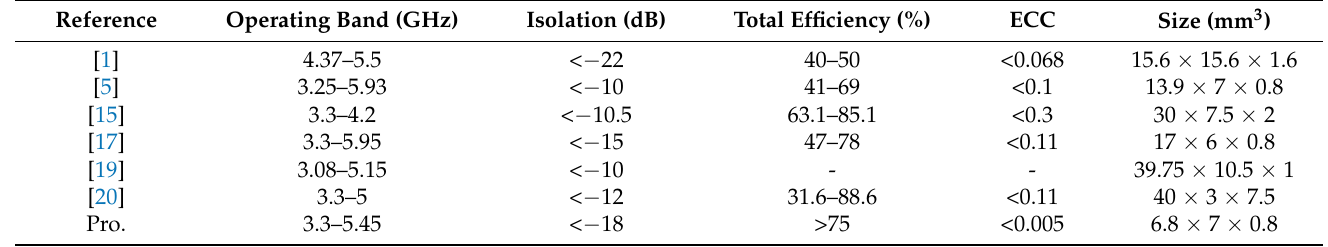
Table 1. Performance comparison of the designed antenna with other published